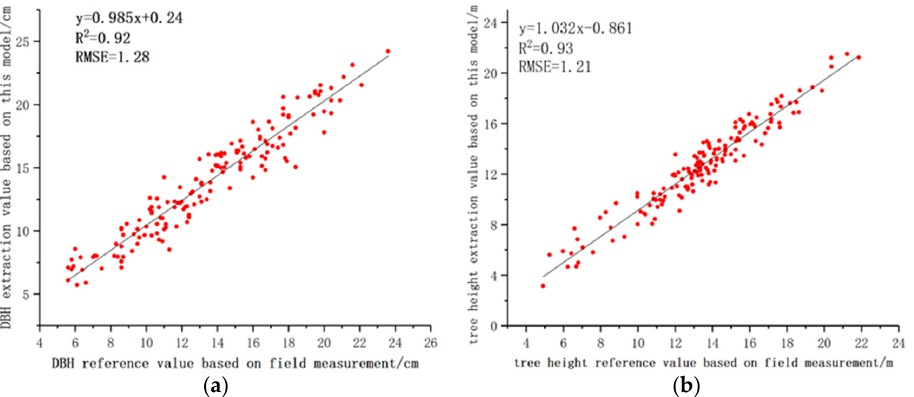
Figure 12. Comparison of the extracted DBH and height values with their reference values. ( a ) DBH; ( b ) tree height.